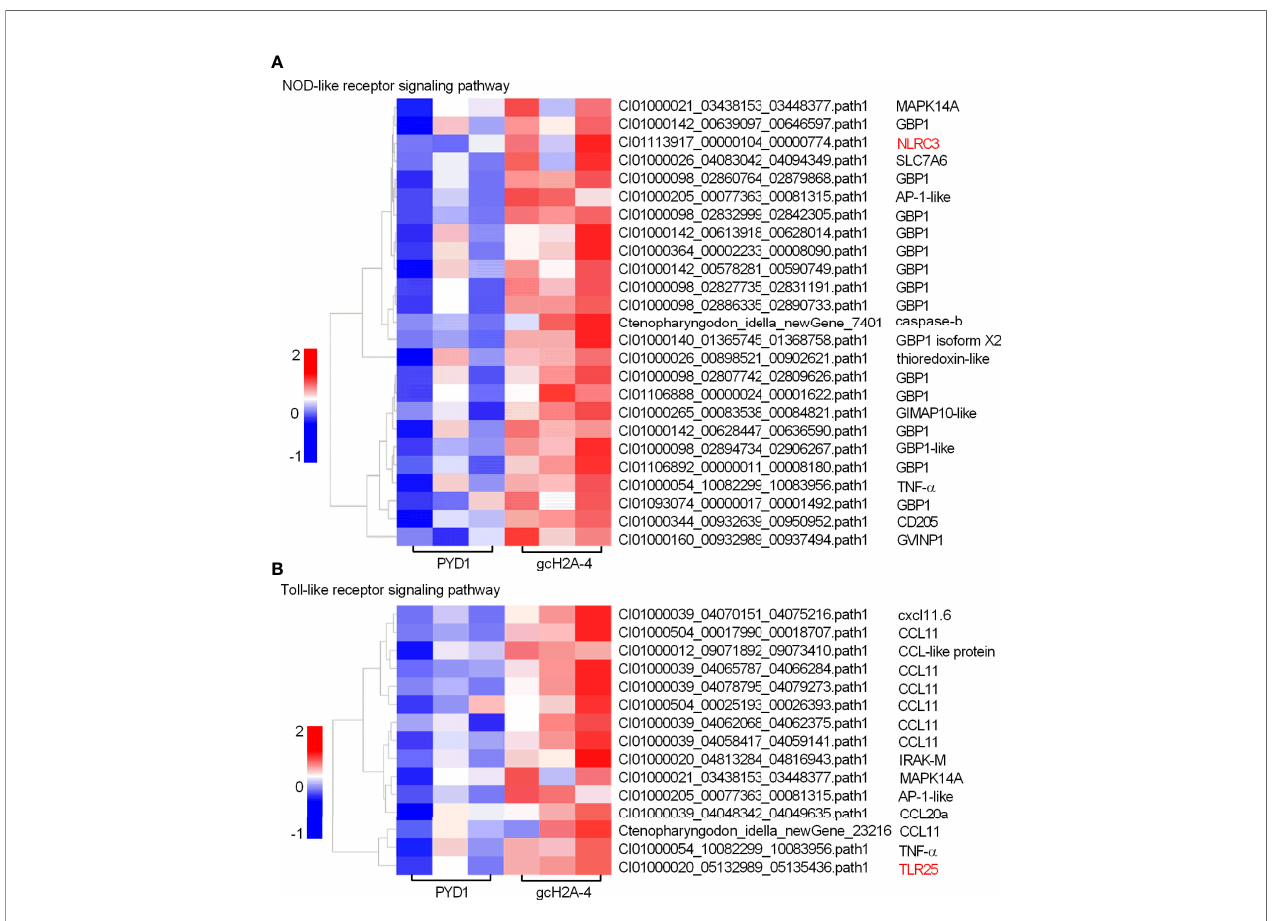
FIGURE 5 | The effects of the engineered S. cerevisiae expressing gcH2A-4 on the expression patterns of DEGs involved in PRRs-mediated signaling pathways. (A) The gene cluster for DEGs involved in the NOD-like receptor signaling pathway for the samples from the intestines of grass carp after 7 days of the fi rst immunization. (B) The gene cluster for DEGs involved in the Toll-like receptor signaling pathway for the samples from the intestines of grass carp after 7 days of the fi rst immunization. A color key denotes the gradient scale of gene expression from low (blue) to high (red) degrees. The receptors of NLR and TLR are